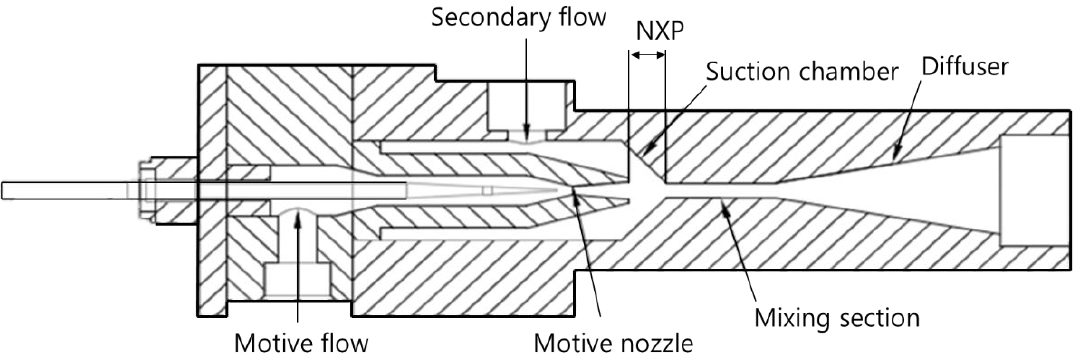
Figure 3. Cross-sectional diagram of a tested ejector. Table 1. Specifications of system components and tested ejector. Component